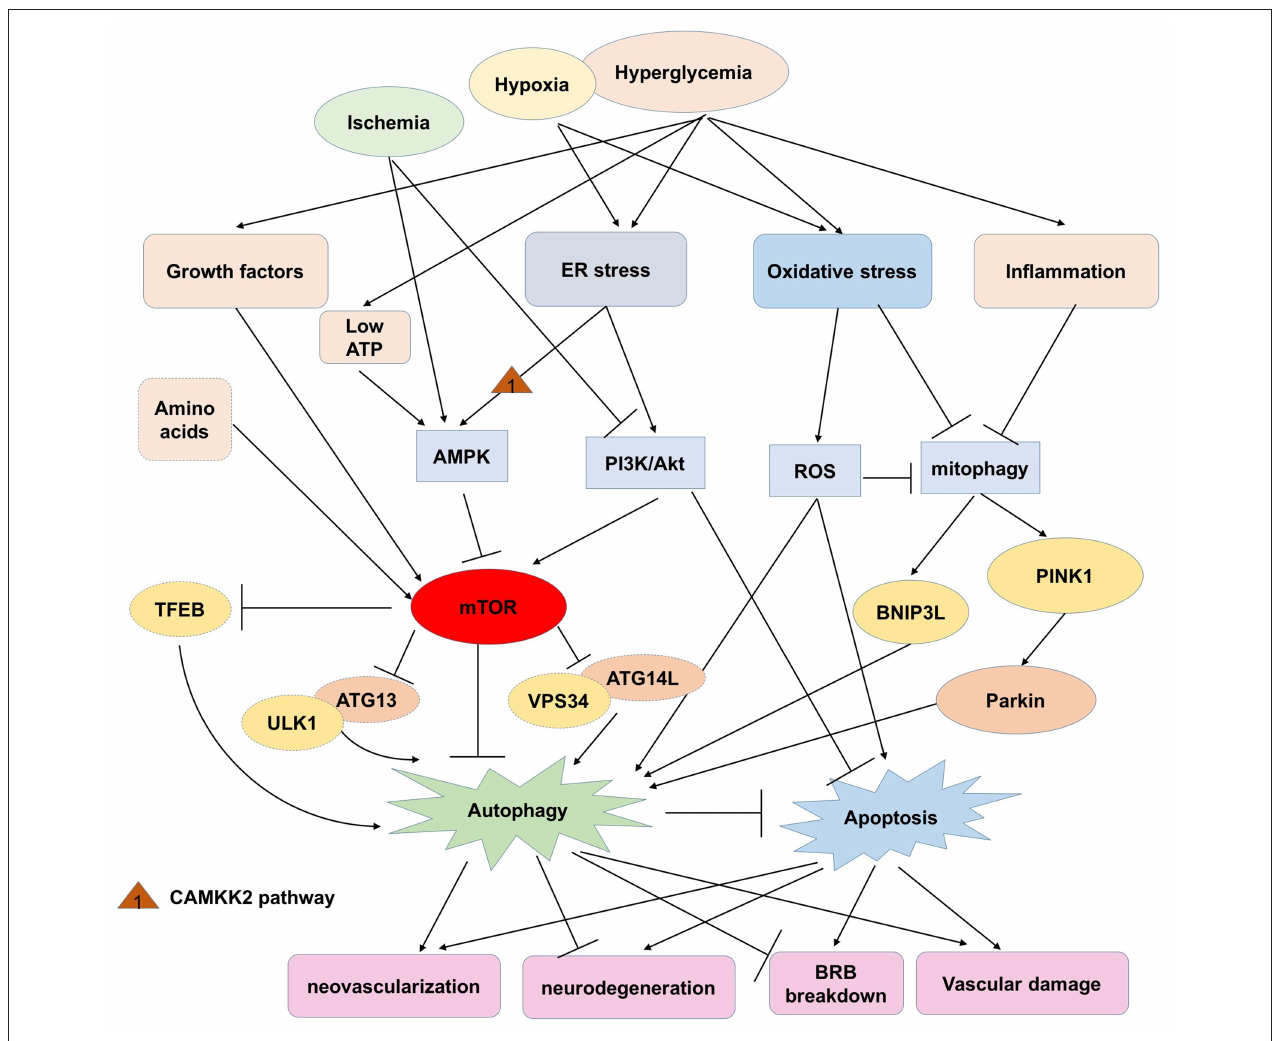
FIGURE 2 | The potential roles and related pathways of autophagy in DR.